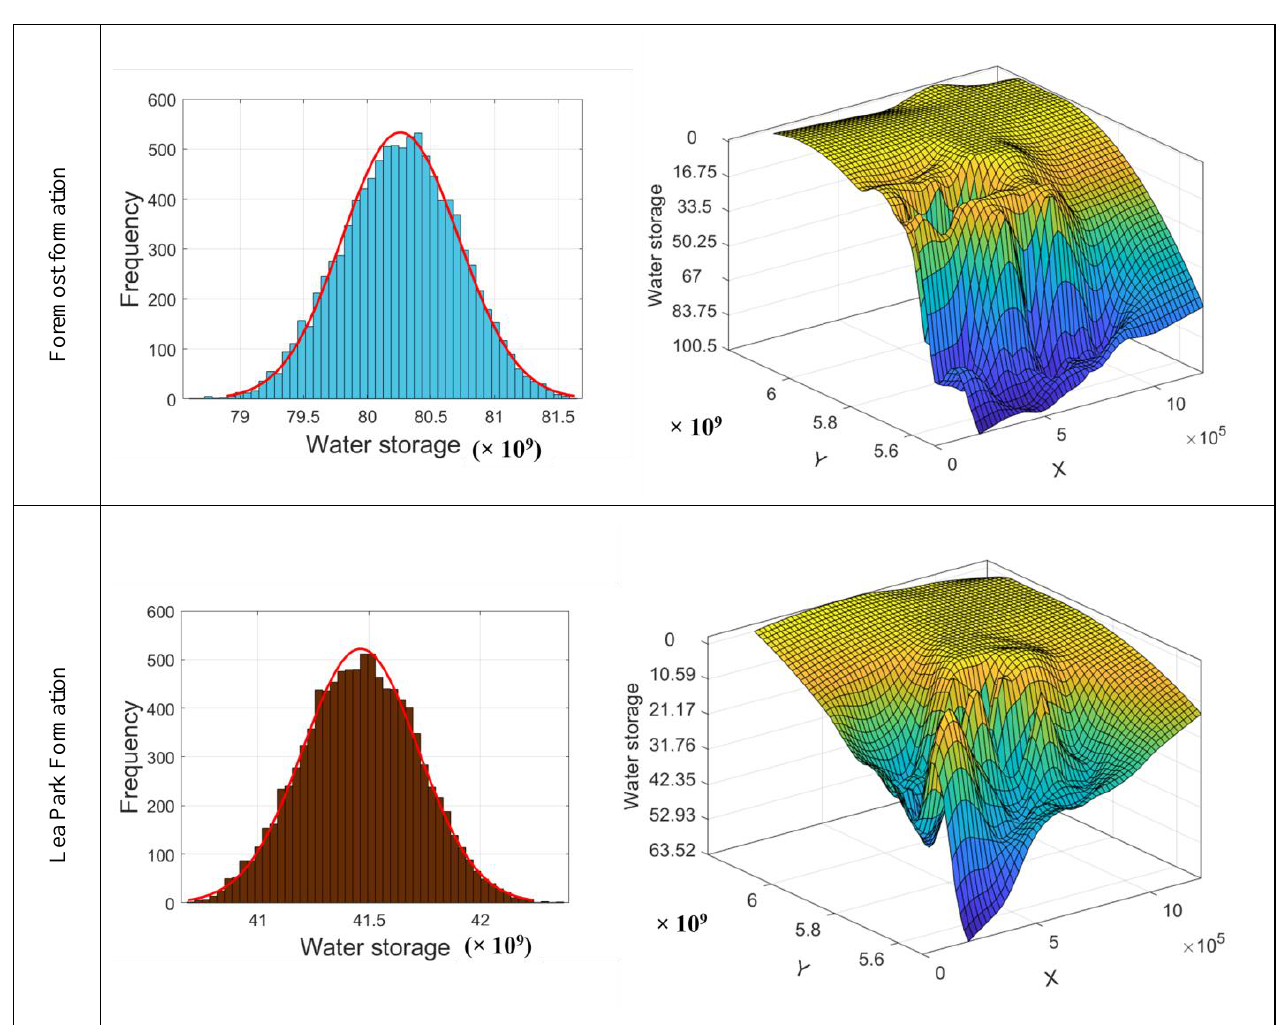
Figure 13. Variation of the maximum geological reserves of the different modeled formations.